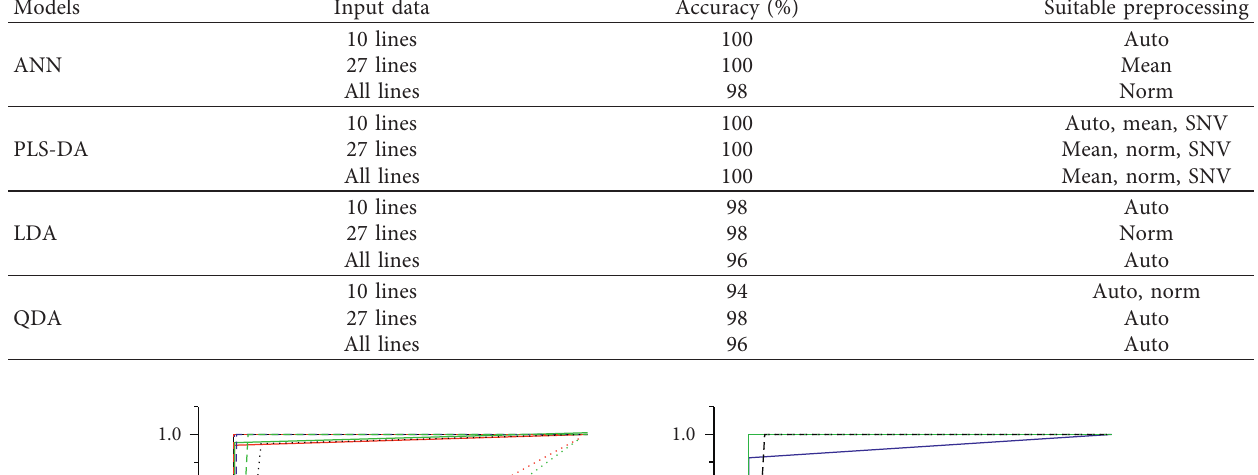
Table 2: Optimal accuracy of different models along with suitable preprocessing methods.